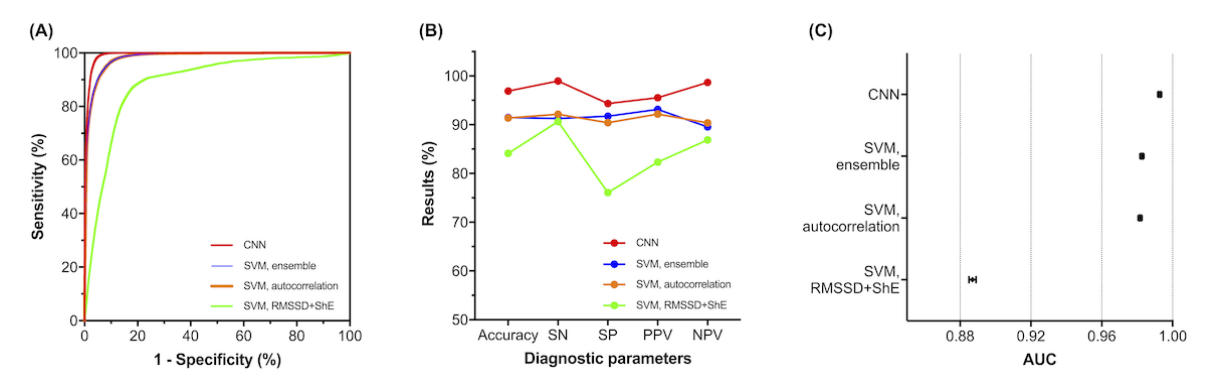
Figure 2. Diagnostic performance of CardioTracker (CART) according to the algorithms. CART with the deep learning algorithm achieved the highest results for all diagnostic parameters. (A) ROC curves, (B) Diagnostic parameters, and (C) AUCs according to the algorithms. AUC: area under the curve, CNN: convolutional neural network, NPV: negative-predictive value, PPV: positive-predictive value, ROC: receiver operating characteristic, SN: sensitivity, SP: specificity, SVM, autocorrelation: support vector machine with autocorrelation as a feature, SVM, RMSSD+ShE: support vector machine with root mean square of the successive differences of RR intervals and Shannon entropy as features, SVM, ensemble: support vector machine with all three